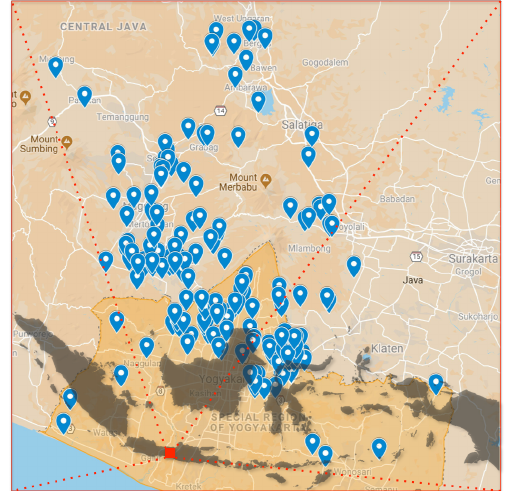
Figure 2. Distribution of Candis in the center of Java (based on data by Degroot,